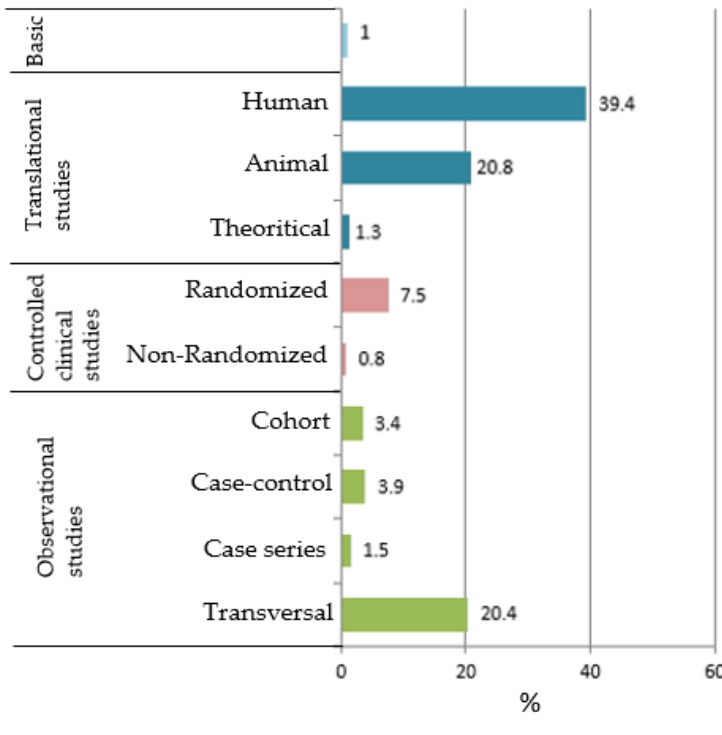
Figure 5. Distribution of article types.